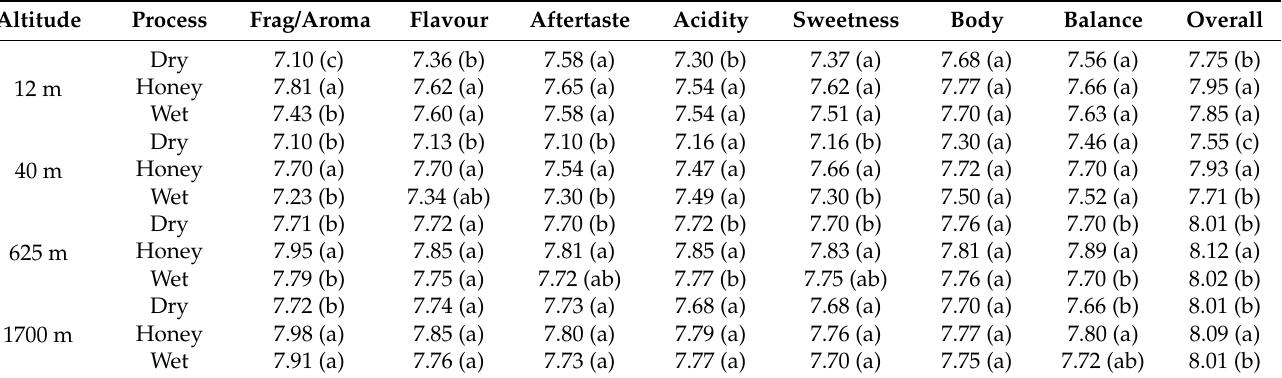
Table 5. Summary of means from Tukey’s HSD test for conilon according to sensory